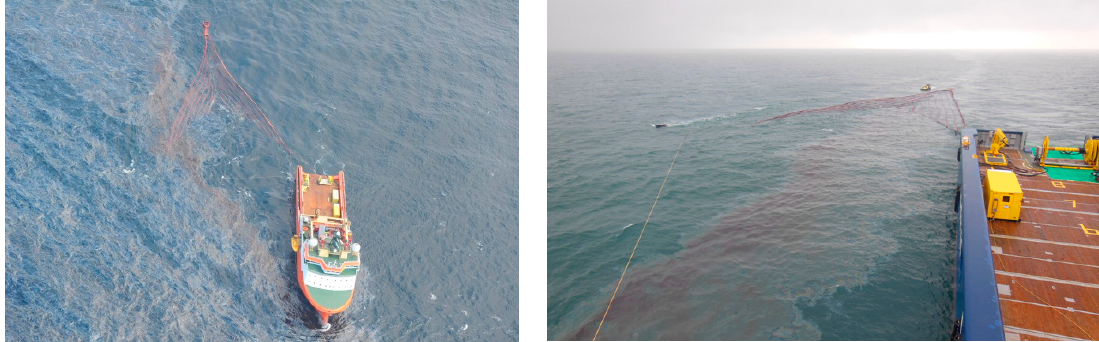
Figure 1. MOS Sweeper [10] mechanical recovering system operated by NOFO during trial at sea (photographs provided by NOFO).